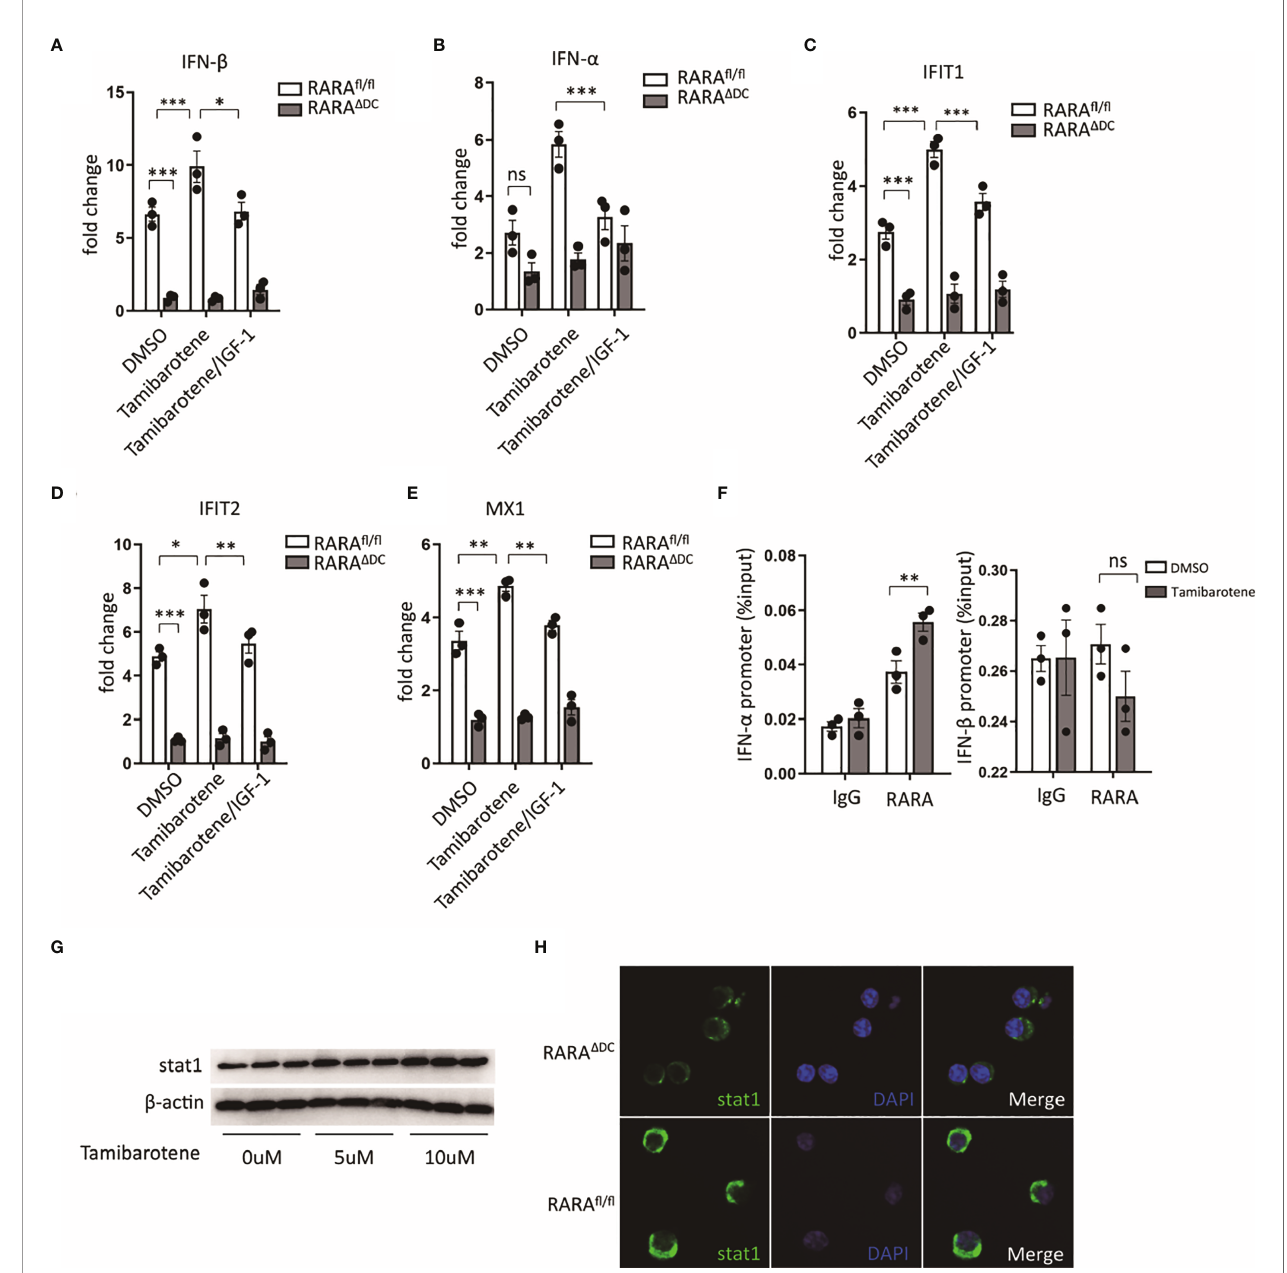
FIGURE 4 | Retinoic acid receptor alpha regulates type I interferons and stat1 expression. (A – E) BMDCs cultured from RAR a fl / fl and RAR a D DC mice, were treated with DMSO, Tamibarotene (4mM) alone or with IGF-1 (500ng/ml), then mRNA expression of IFN- a , IFN- b , and ISGs (IFIT1, IFIT2, MX1) were determined by RT-PCR. (F) ChIP-qPCR for RAR a at IFN- a , and IFN- b regulatory element in BMDCs cultured from SPF mice. (G) BMDCs from SPF mice were treated with different concentration of tamibarotene (respectively 0uM, 5uM, 10uM), and stat1 protein expression were measured by western blotting. (H) stat1 expression in BMDCs from RAR a fl / fl and RAR a D DC mice were detected by immuno fl uorescence method. Data are from at least two independent experiments. Graph shows mean and SEM. Data were analyzed by one-way ANOVA. *p < 0.05, **p < 0.01, ***p < 0.001. ns, not signi fi